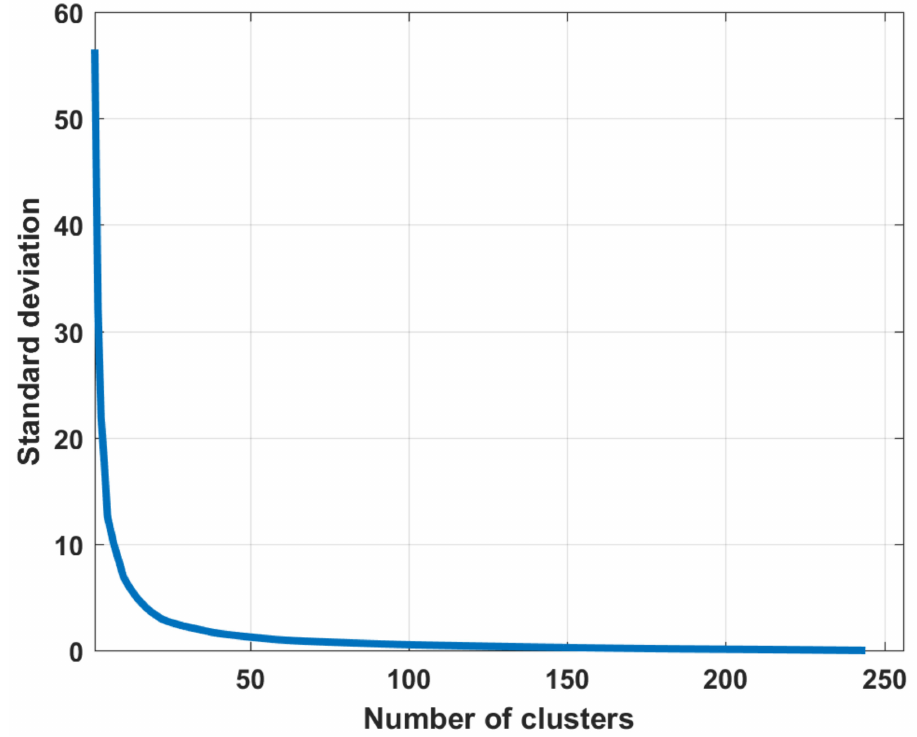
Figure 5. The dependence of the values of the standard deviations σ on the number of clusters in the partition.